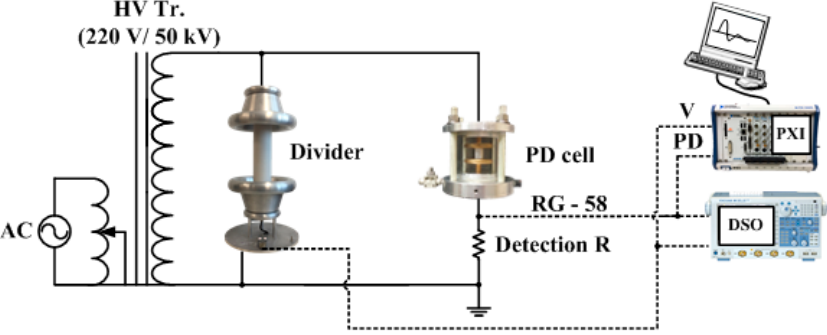
Figure 3. Experimental setup.